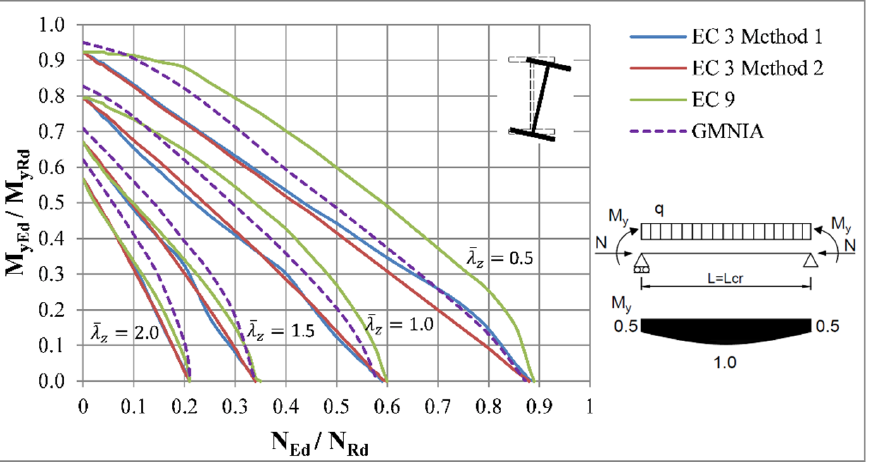
Figure 25. Interaction curves for laterally unrestrained beam-columns with IPE 100 cross-section with free warping.